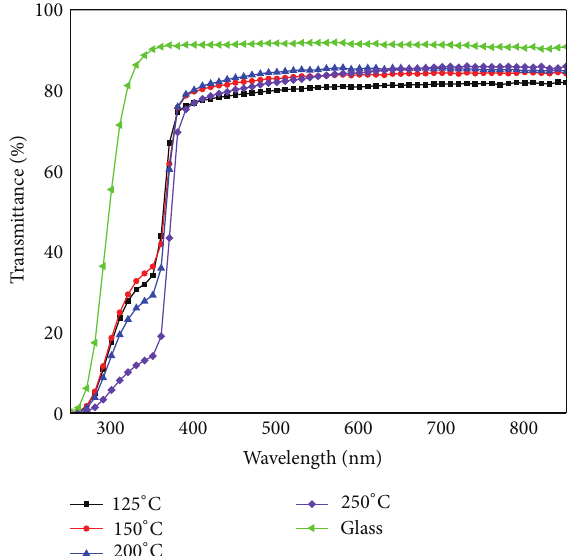
Figure 7: J - V characteristics of devices with ZnO ETLs prepared with different thicknesses.